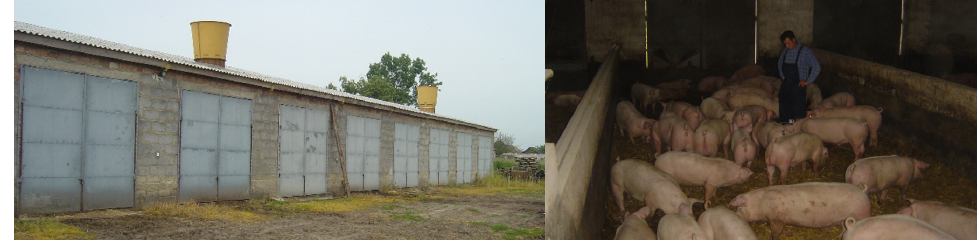
Figure 2. The studied piggery for fattening pigs (authors photo).